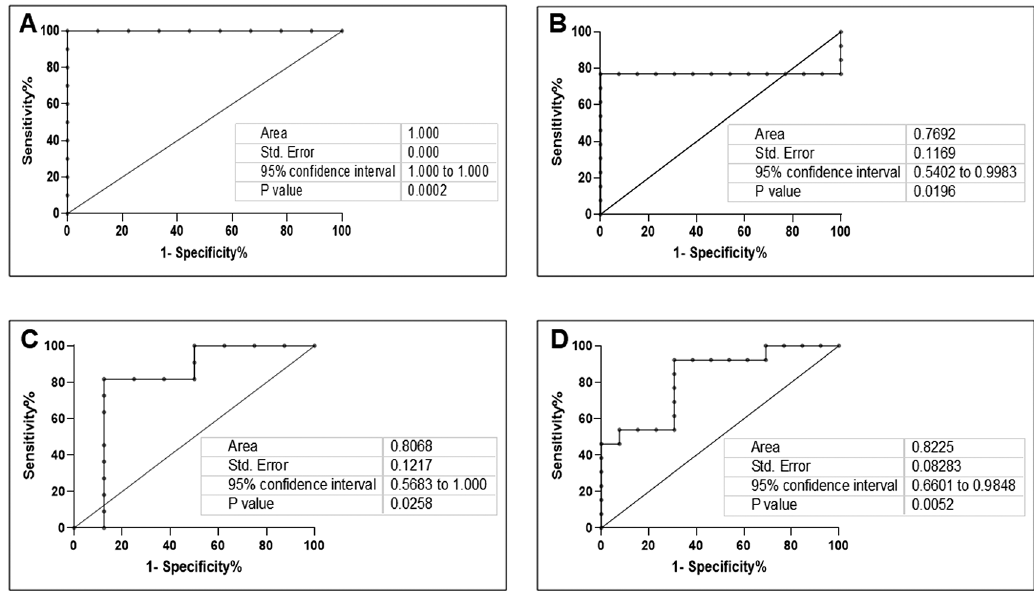
Figure 5. Receiver operating characteristic curve (ROC) showing the plot and the best cut-off point of the relationship between the mRNA expression of ACE2 and C. albicans or A. actinomycetemcomitans in DG (A and C) and NDG (B and D),